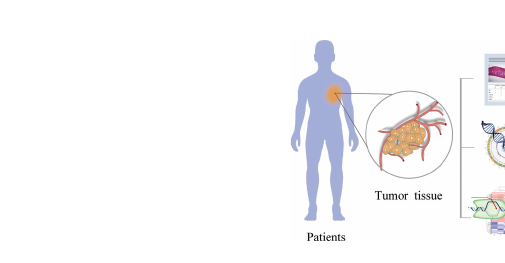
FIGURE 6 | The integrated strategies for